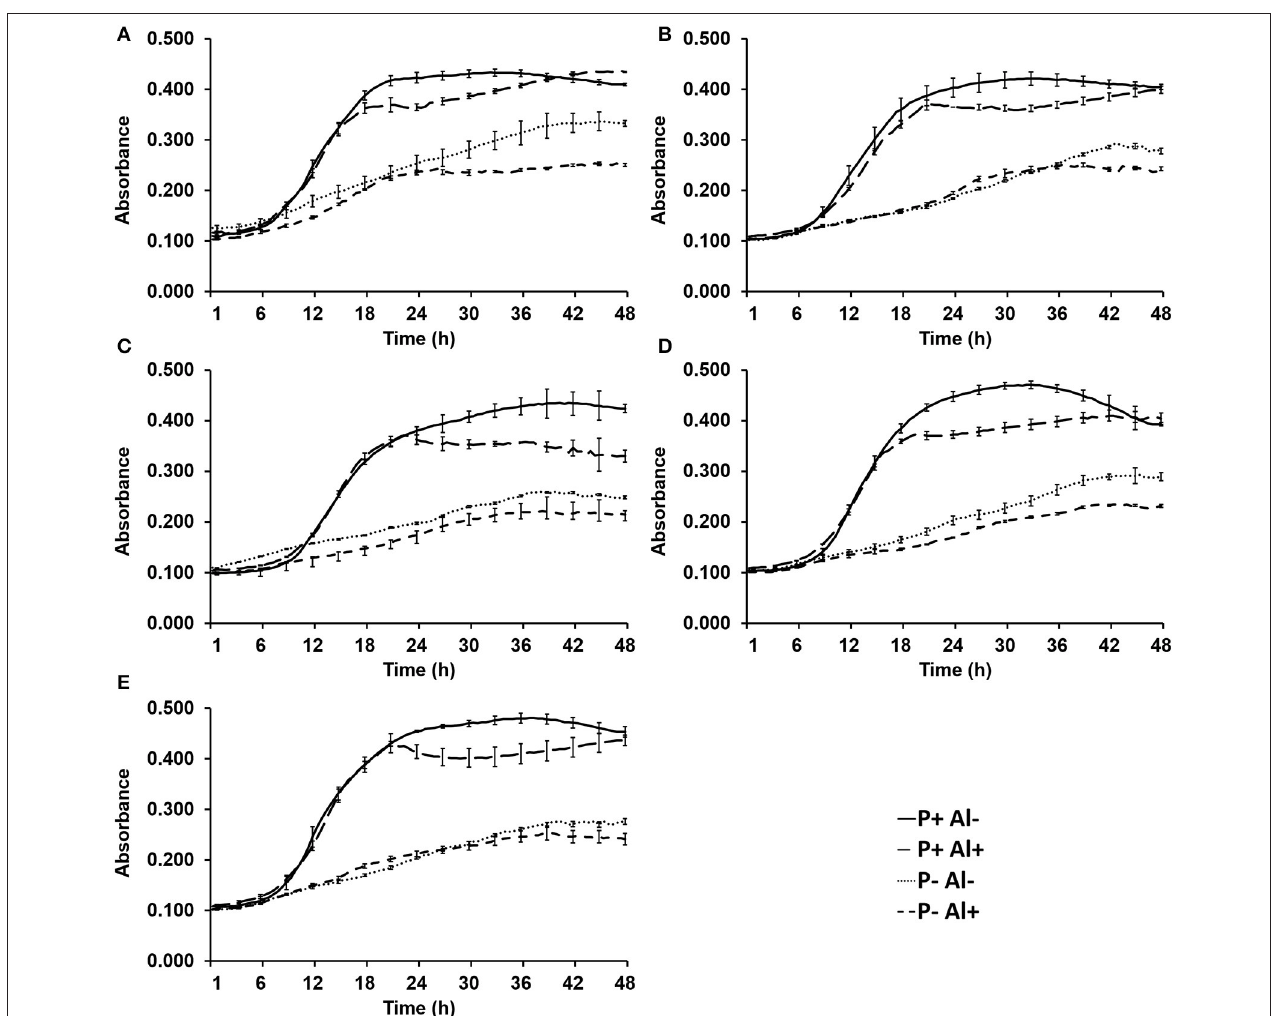
FIGURE 1 | Growth of selected phosphobacteria strains (A) Klebsiella sp. RC3, (B) Stenotrophomonas sp. RC5, (C) Klebsiella sp. RCJ4, (D) Serratia sp. RCJ6, and (E) Enterobacter sp. RJAL6 in a modified mineral culture medium (MCM) with contrasting P and Al concentrations. P + : 1.4mM KH 2 PO 4 ; P–: 0.05mM KH 2 PO 4 ; Al + : 10mM AlCl 3 × 6H 2 O; Al–: without Al